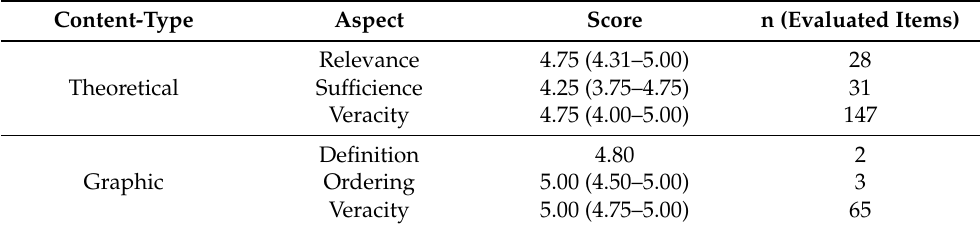
Table 9. Delphi validation results of the “Work of Breathing Indexes” model, organized by aspects evaluated and scored from 1 to